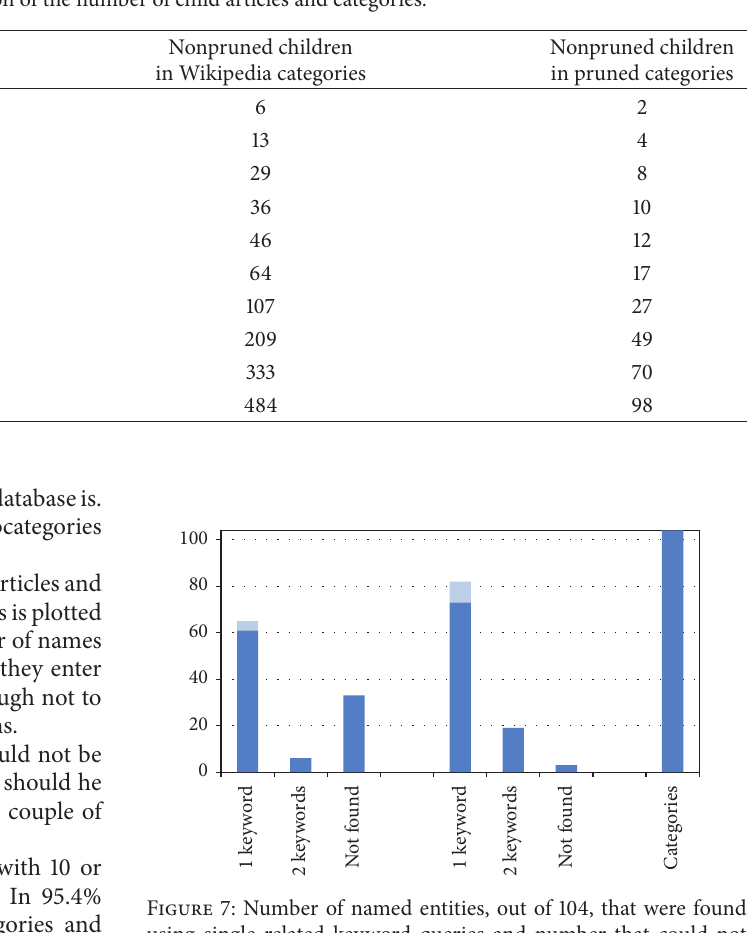
Table 2: Distribution of the number of child articles and categories.